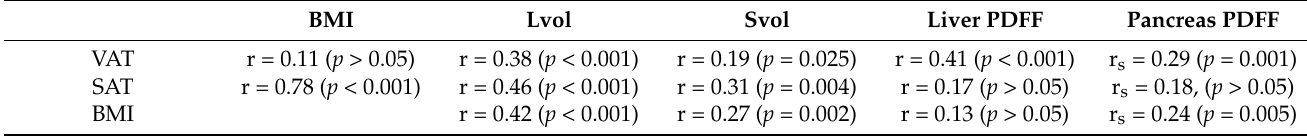
Table 1. Correlation among VAT, SAT, BMI and Lvol, Svol, liver and pancreas PDFF in the study cohort *. BMI Lvol Svol Liver PDFF Pancreas